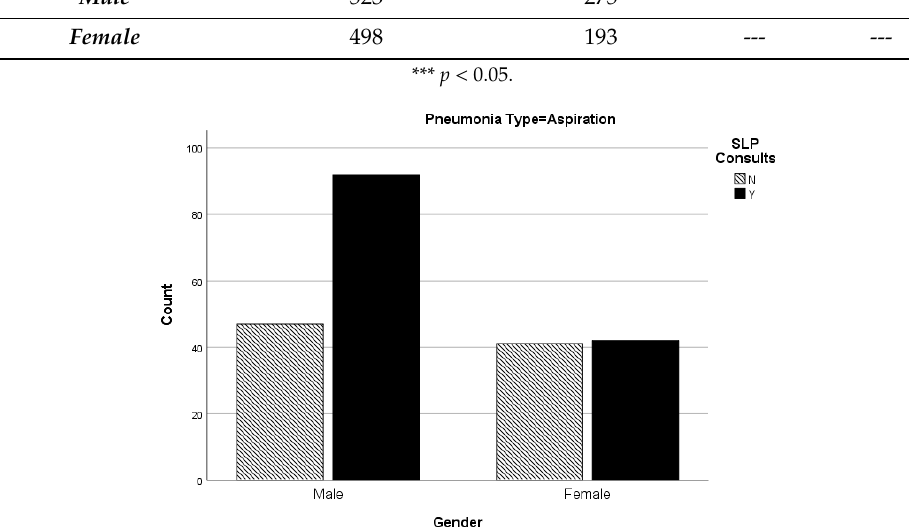
Figure 1. Number of SLP consults from each age category for aspiration pneumonia.